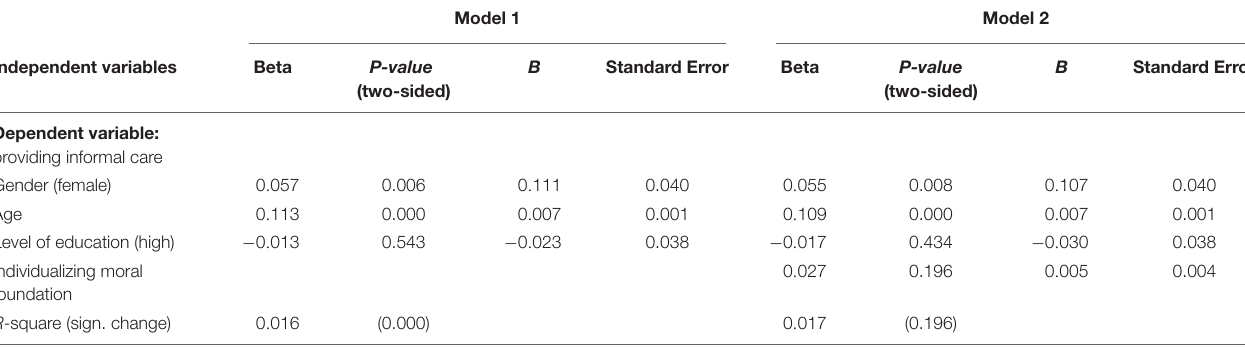
TABLE 9 | Coefficients of regression models predicting voluntary behavior and informal care (Study